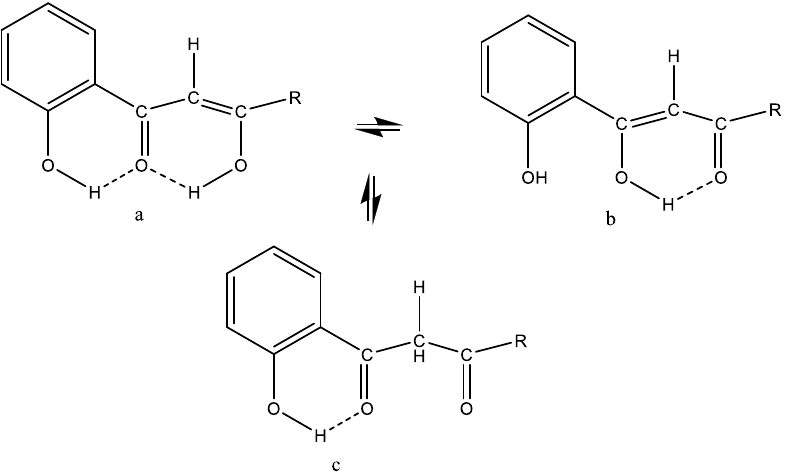
Figure 3. Tautomeric equilibrium of a β -diketone system. ( a , b ) are in fast equilibrium. ( c ) the keto form is in a slow equilibrium with the enol